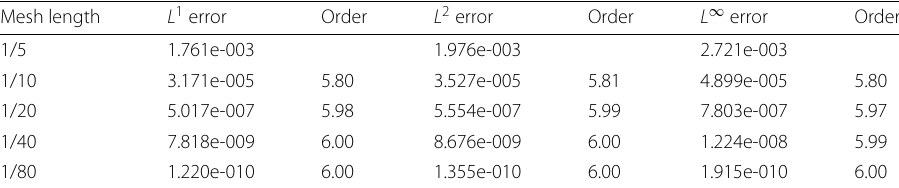
Table 1 1-D accuracy test: errors and convergence orders of 6th-order compact linear scheme with (cid:10) t = 0.3 (cid:10) x 3 / 2 Mesh